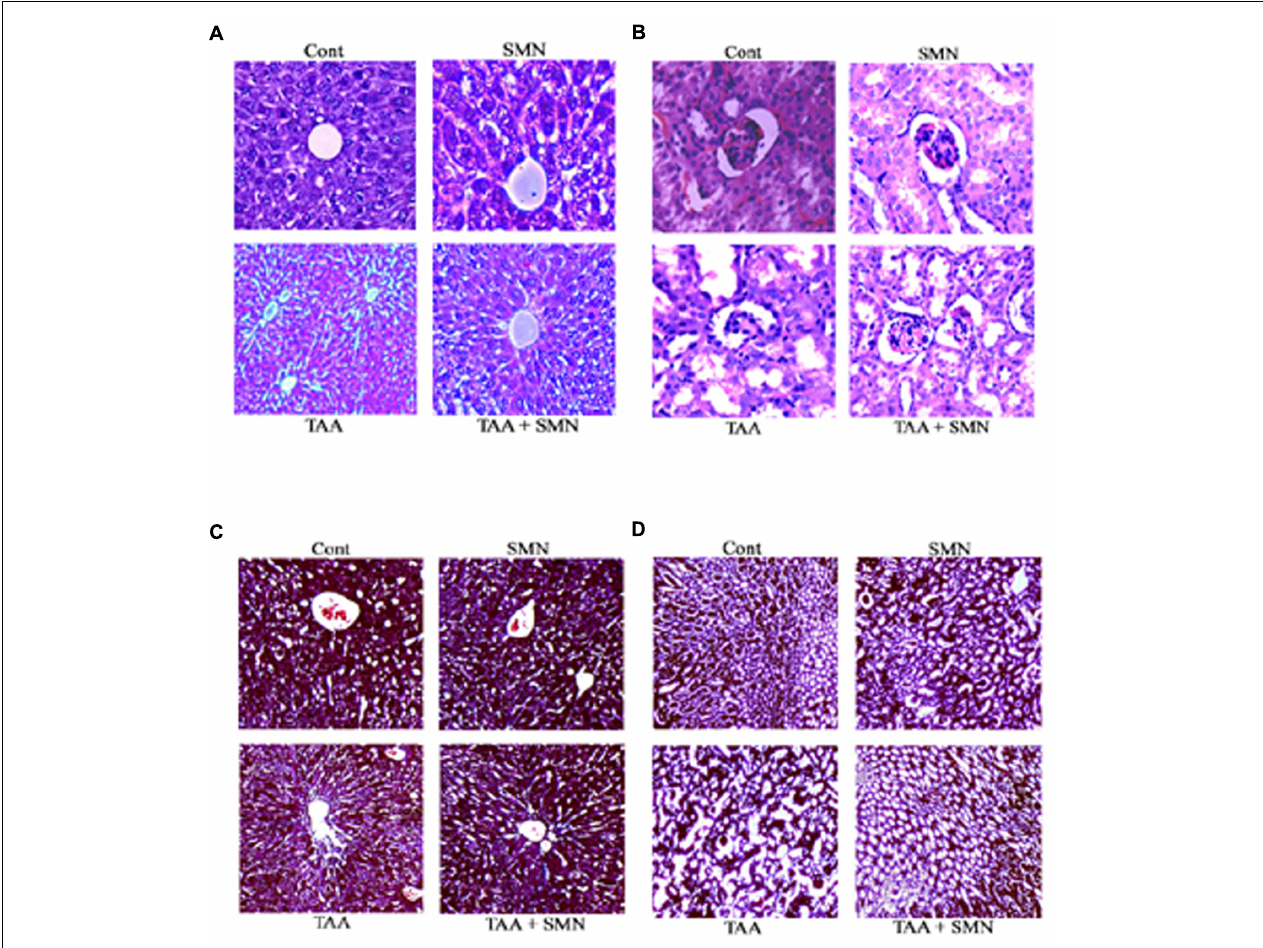
FIGURE 5 | Histological observations. Hematoxylin and eosin staining of liver (A) and kidney (B) . Cont: normal tissues (10 × ); TAA: TAA exposed (100 mg/kg body weight for 56 days) tissues (10 × ); SMN: SMN treated (150 mg/kg body weight for 56 days) tissues (10 × ); TAA + SMN: tissues from animals treated with SMN (150 mg/kg body weight in olive oil orally for 8 weeks) after TAA administration twice a week for 56 days (10 × ). Masson’s Trichrome staining of liver (C) and kidney (D) . Cont: normal tissues (10 × ); TAA: TAA exposed (100 mg/kg body weight for 56 days) tissues (10 × ); SMN: SMN treated (150 mg/kg body weight for 56 days) tissues (10 × ); TAA + SMN: tissues from animals treated with SMN (150 mg/kg body weight in olive oil orally for 8 weeks) after TAA administration twice a week for 56 days (10 ×